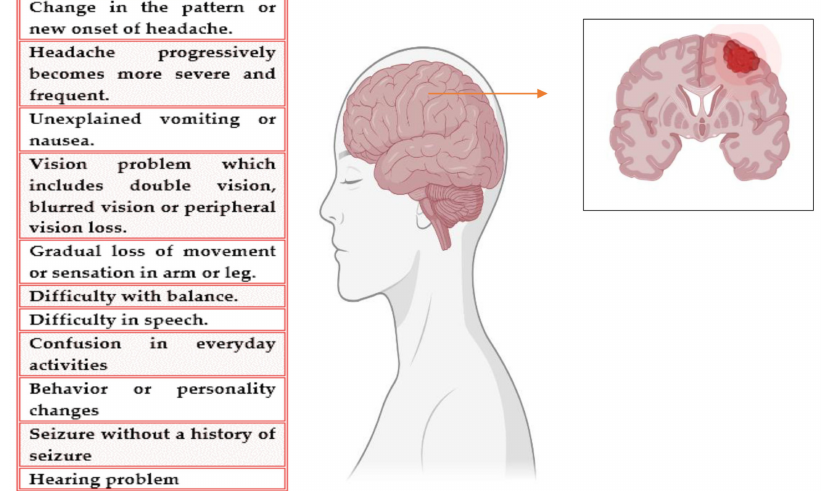
Figure 1. Symptoms of BT.